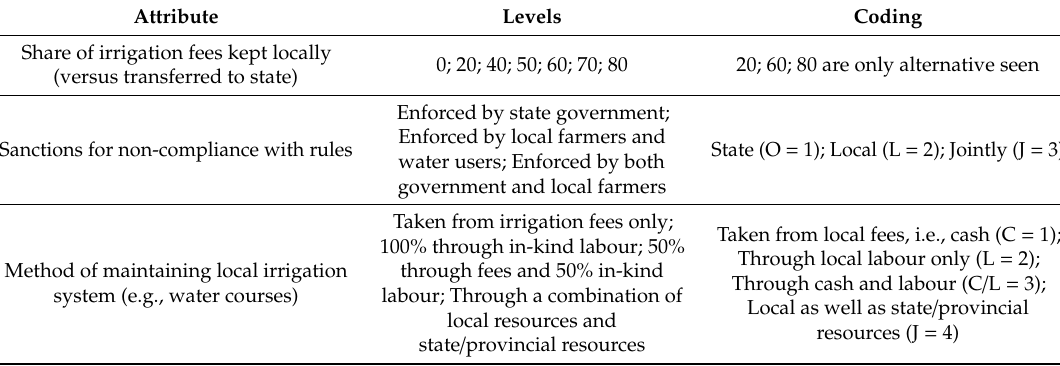
Table 2. DCE 2: Attributes, levels and coding for governance experiment. Attribute Levels